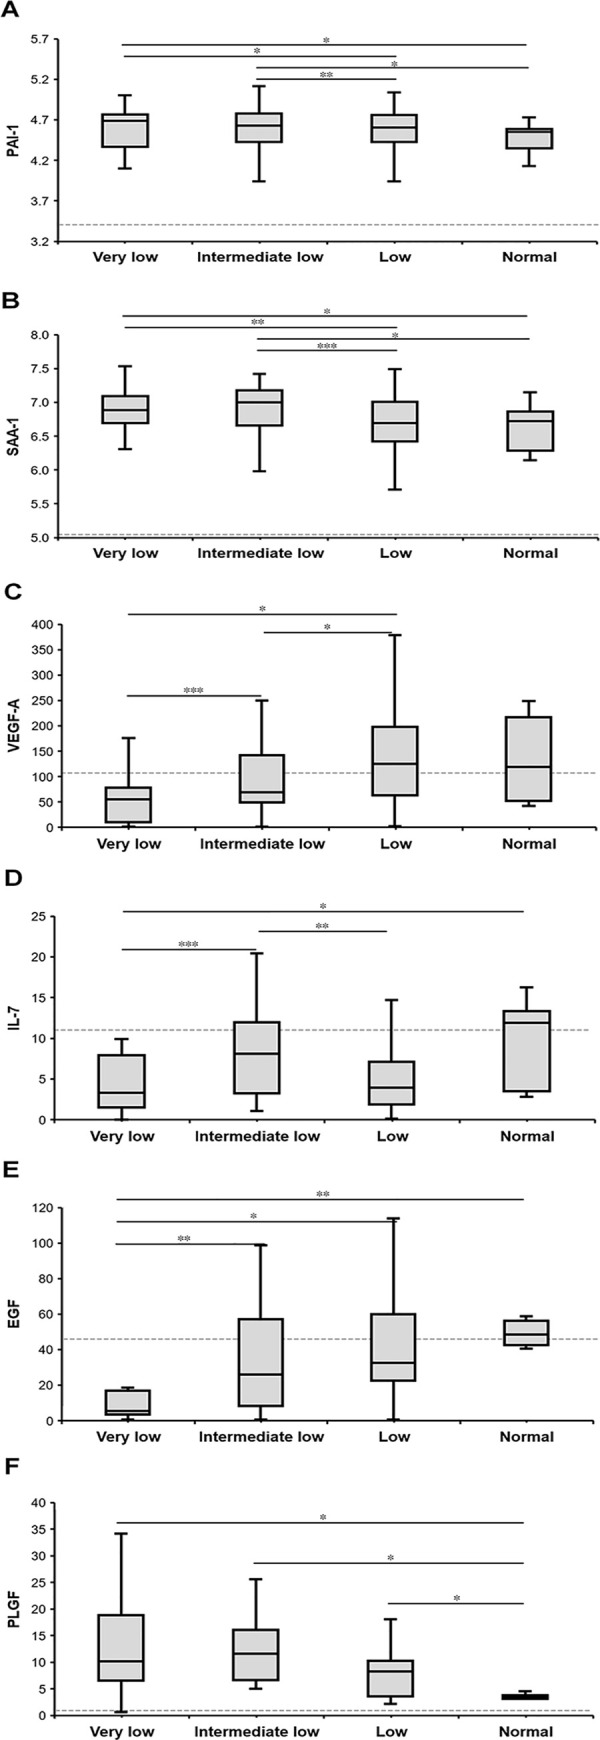
Cytokine levels in SFTS patients in the four groups with different PLT counts at the acute phase.A, PAI-1, plasminogen activator inhibitor 1; B SAA-1, serum amyloid antigen 1; C, VEGF-A, vascular endothelial growth factor A; D, IL-7, interleukin 7; E, EGF, epidermal growth factor; F, PLGF, placental growth factor. *P<0.05 using nonparametric test; **P<0.01 using nonparametric test; ***P<0.001 using nonparametric test. Data are expressed as box plots with the median, lower quartile, upper quartile, minimum and maximum.